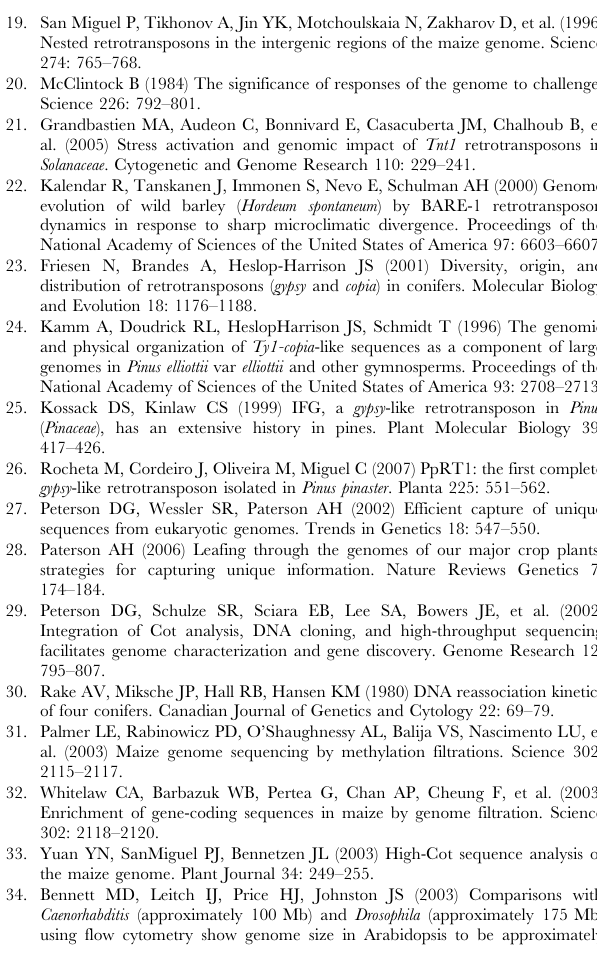
Figure S1 Translated sequence alignment of Gypsy RT polymerase domains. The five RT polymerase motifs (defined by Poch et al. 1989. EMBO J. 8: 3867–3874) are indicated by black bars (A to E). Identical amino acid residues are indicated by an asterisk, conservative and semi-conservative substitutions with a colon and period, respectively. Accession numbers are